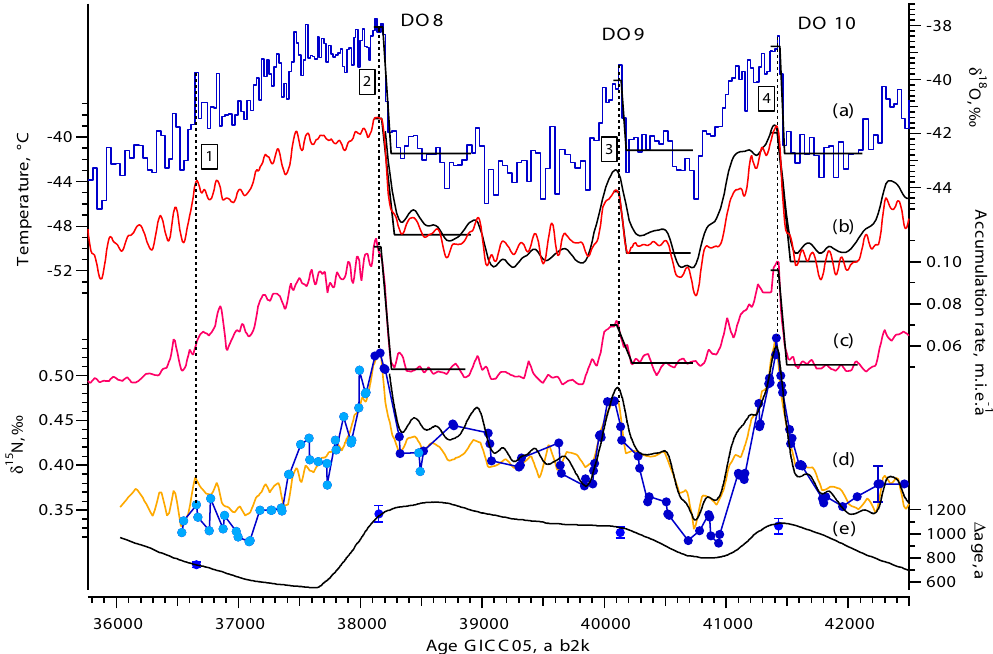
Fig. D1 δ 15 N reconstruction for NGRIP. (a) , δ 18 O profile used to reconstruct the surface temperature profile, NGRIP members (2004). (b) Surface temperature scenario used in the Goujon model (red line, this study) and in Huber et al. (2006), black line. Note that the temperature reconstruction covering DO 8 was missing at that time. (c) Accumulation scenario for the Goujon model. (d) Measured δ 15 N data at the University of Bern, Switzerland, with error bar shown on the last point to the right (dark blue dots Huber et al. (2006), new points in light blue dots). Modeled δ 15 N by the Goujon model (orange line), using temperature and accumulation scenario shown in (b) and (c) . Measured and modeled δ 15 N are plotted on the ice age scale using the 1 age produced by the Goujon model ( e , black line). 1 age tie points are numbered as in Table 2. Black line: modeled δ 15 N from Huber et al. (2006) using the temperature scenario in (b) , black line. (e) Blue markers: tie points between δ 15 N and δ 18 O, used to constrain the firnification models. Black line: 1 age modeled by the Goujon model. Subplots (a) , (b) and (c) , in black: stadial and interstatial mean states calculated by the rampfit